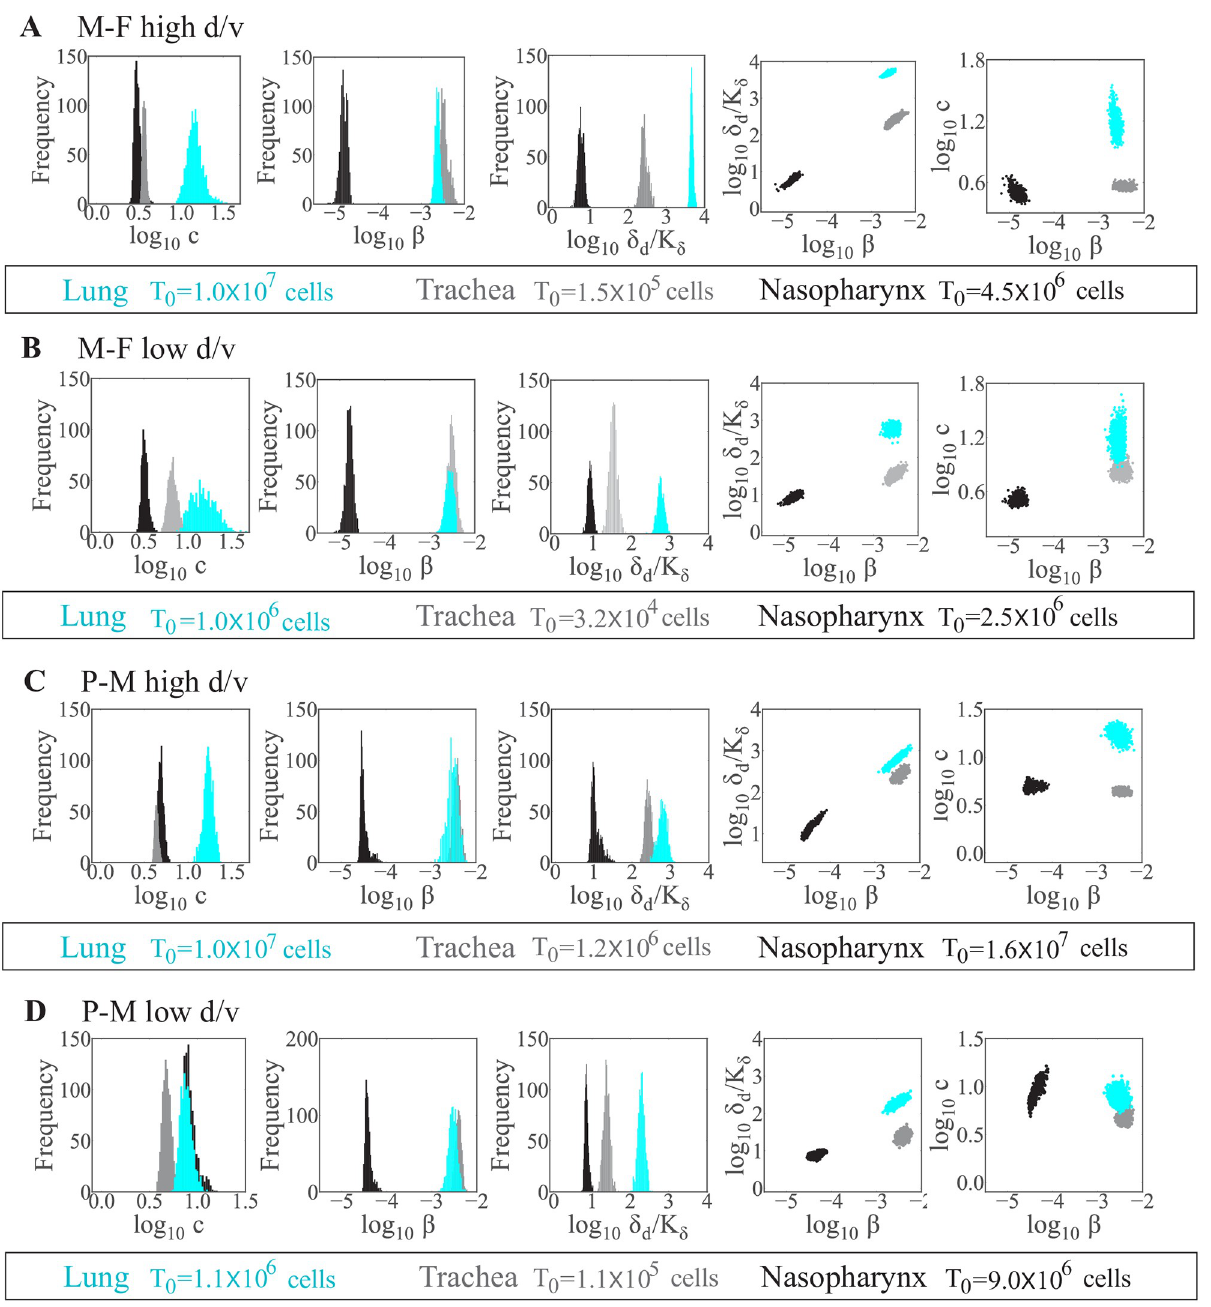
Fig 4. Respiratory tissue-dependent parameters. Comparison of parameter histograms and ensembles resulting from fitting the model (Eqs (3)–(6)) to estimated viral loads from the lung (cyan), trachea (gray), or nasopharynx (black) of mice infected with the rSeV-luc(M-F � ) virus (“M-F”) at high d/v (Panel A) or low d/v (Panel B), or infected with the rSeV-luc(P-M) virus (“P-M”) at high d/v (Panel C) or low d/v (Panel D). Parameters shown are virus clearance ( c ), virus infection ( β ), and infected cell clearance ( δ / K δ ). Additional histograms and ensemble plots are in Figs H-K in S1 d